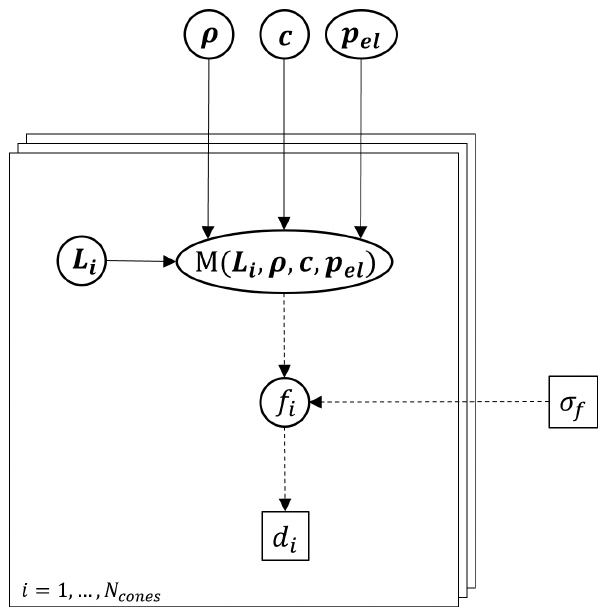
Figure 3. Directed acyclic graph (DAG) for the problem of muon tomography. Variables in a square ( (cid:3) ) denote fixed; i.e. known val- ues and variables in a circle/ellipse ( (cid:13) ) are generally unknown and have to be represented by a PDF. Solid arrows ( → ) denote a de- terministic relation, i.e. within a physical model, whereas dashed arrows ( ) indicate a probabilistic relationship, i.e. a parame- ter within the statistical description of the variable. ρ , c are the density and composition for different materials, whereas p el con- tains the errors on the different processes in the energy-loss equa- tion. σ f describes the error on the cosmic-ray flux model. Within each cone, L i denote the thicknesses of rock and ice, respectively, M ( L i , ρ , c , p el ) is the calculated flux (i.e. energy-loss model and flux model combined), f i the actual muon flux and d i the observed number of muon